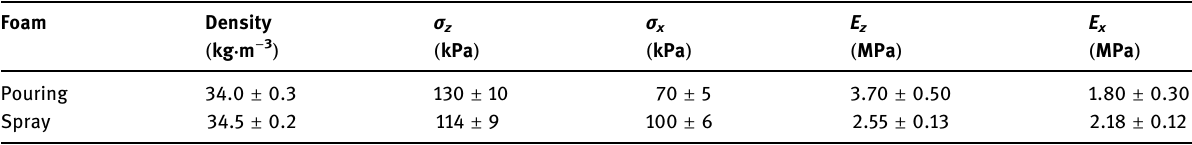
Table 3: Compressive properties of pouring and spray foams Foam